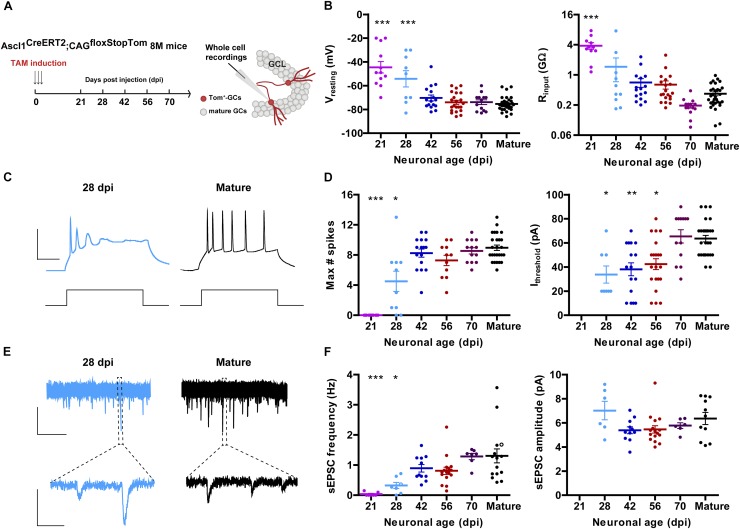
Development of intrinsic excitability and glutamatergic input connectivity in developing GCs from 8 M mice. (A) Experimental design. Ascl1CreERT2;CAGfloxStopTom mice received TAM to label new GCs. Whole-cell recordings were carried out in Tom-GCs at different times after TAM injection in acute slices. (B) Resting potential and input resistance from Tom-GCs and unlabeled mature GCs. (∗∗∗) denotes p < 0.001 compared to mature GCs after ANOVA followed by Tukey’s post hoc test (resting potential) and Kruskal–Wallis followed by Dunn’s post hoc test (input resistance). Sample sizes (presented as neurons/mice): 12/7 (21 dpi), 9/3 (28 dpi), 16/5 (42 dpi), 22/5 (56 dpi), 13/3 (70 dpi), and 30/17 (mature). (C) Representative current-clamp recordings in 28 dpi- (cyan) and mature (black) GCs. Spiking was elicited by depolarizing current steps of increasing amplitude (500 ms, 0–200 pA, 10 pA steps). Scale bars: 50 mV, 50 ms. (D) Maximum number of spikes and current threshold for spiking elicited by depolarizing current steps. (∗), (∗∗), and (∗∗∗) denote p < 0.05, p < 0.01, and p < 0.001 compared to mature GCs after Kruskal–Wallis test followed by Dunn’s post hoc test. Sample sizes: 15/7 (21 dpi), 10/3 (28 dpi), 16/5 (42 dpi), 11/5 (56 dpi), 13/3 (70 dpi), and 30/17 (mature). (E) Representative traces of EPSCs recorded at –70 mV from 28 dpi- (cyan) and mature (black) GCs. Top, time-compressed traces allow the visualization of sEPSC frequency. Bottom, expanded presentations show individual events. Calibration: top, 10 pA, 5 s; bottom, 5 pA, 50 ms. (F) Frequency of sEPSC events measured during 120 s (left) and sEPSC amplitude presented as mean value for each cell (right). Open circles correspond to sample traces. (∗) and (∗∗∗) denote p < 0.05 and p < 0.001 compared to mature GCs after Kruskal–Wallis test followed by Dunn’s post hoc test. Sample sizes: 7/7 (21 dpi), 7/3 (28 dpi), 11/5 (42 dpi), 16/5 (56 dpi), 7/3 (70 dpi), and 15/12 (mature). Horizontal bars denote mean ± SEM.